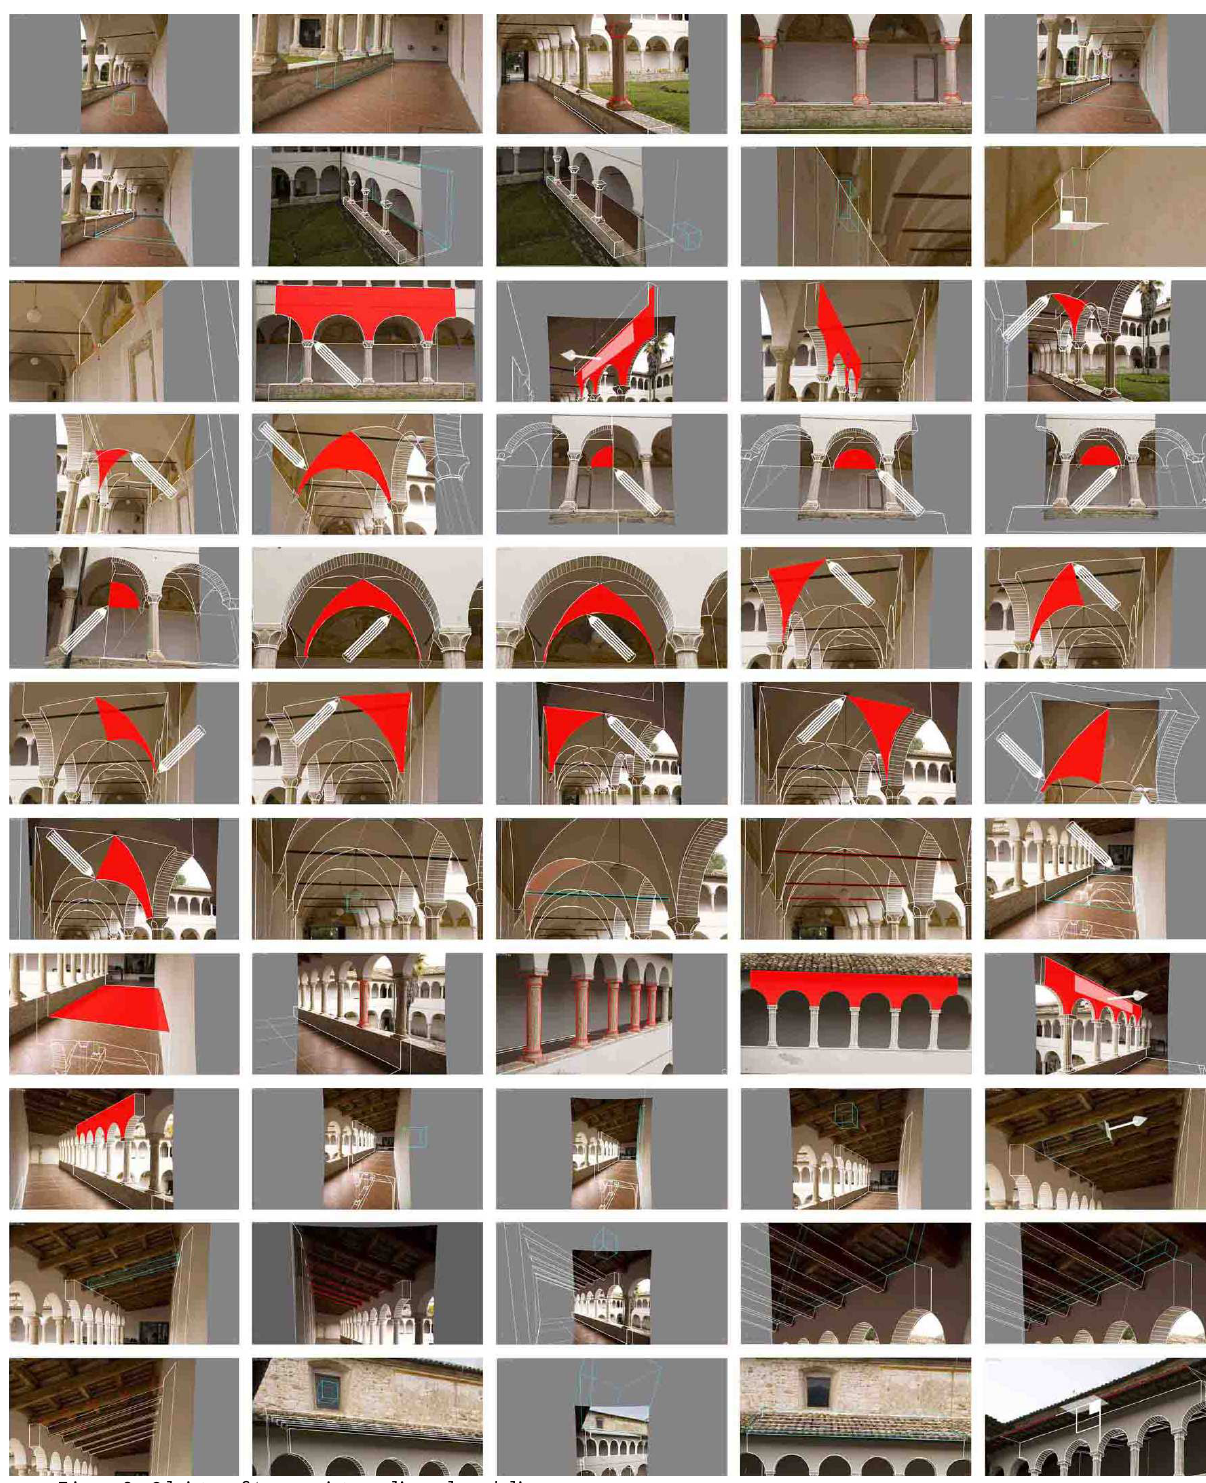
Figure 8. Cloister of Annunziata: poligonal modeling project that may need accurate geometrical